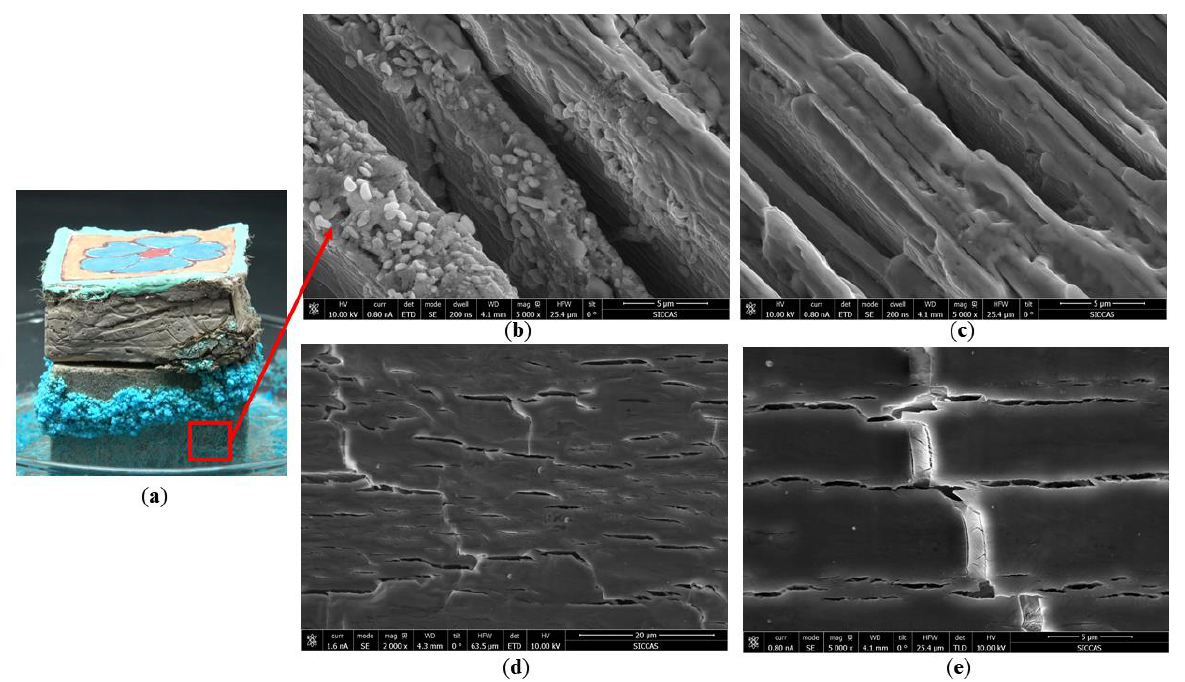
Figure 8. Images of crystals forming the salt crust ( a ) salt crust on the surface; ( b ) SEM salt crust photo; ( c ) SEM salt crust photo in another location; ( d ) cross-sectional morphology of the salt crust, 1000×; ( e ) cross-sectional morphology of the salt crust, 5000×.